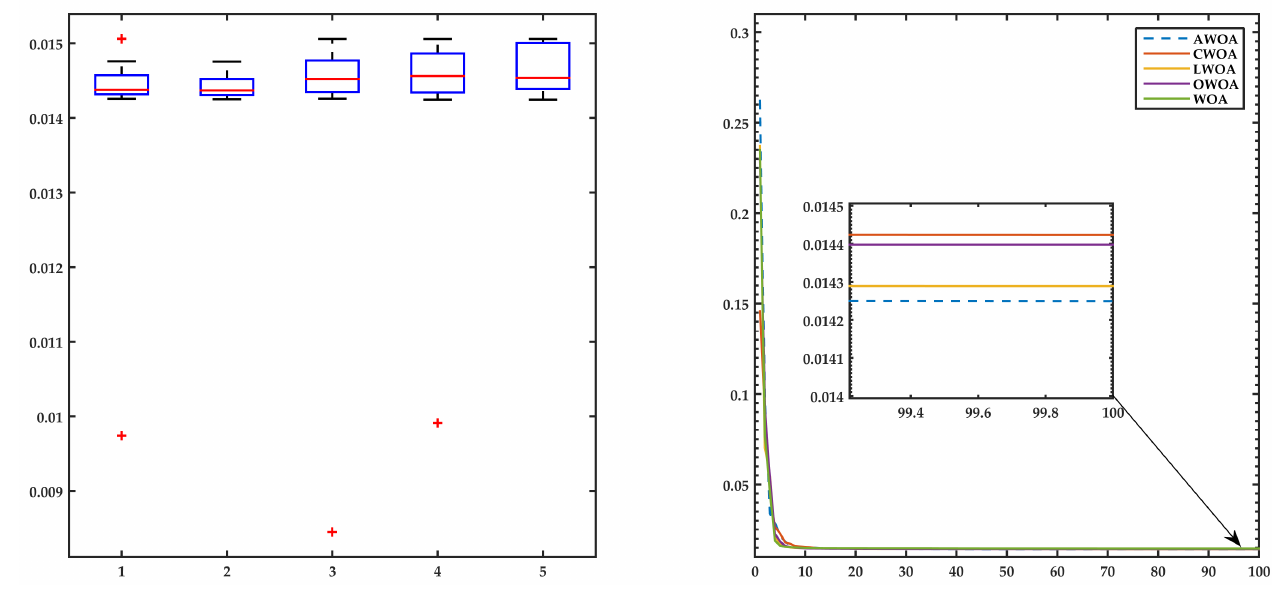
Figure 18. Comparative results of different controllers for DC motors.